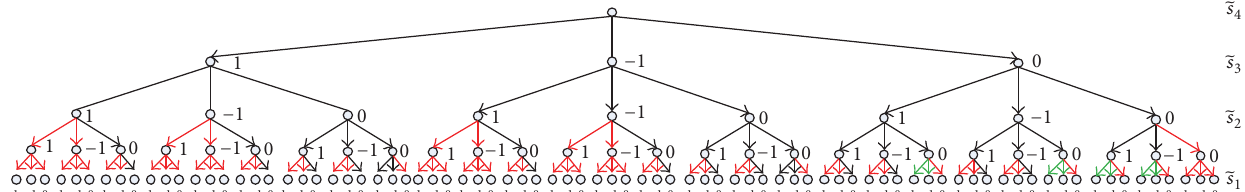
Figure 1: An example of the inverted tree for the original QRD-M algorithm with 𝑁 𝑡 = 4 , 𝑁 𝐴 = 2 , and BPSK modulation.